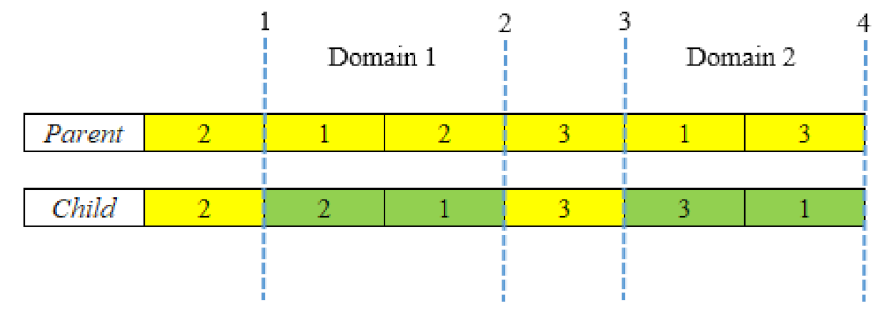
Figure 4. Working of double-inversion mutation operator